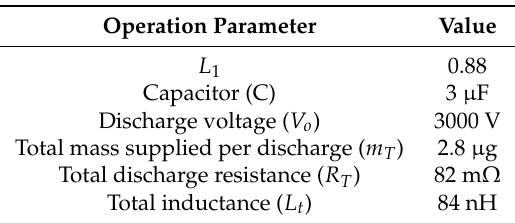
Table 2. Operation parameter for